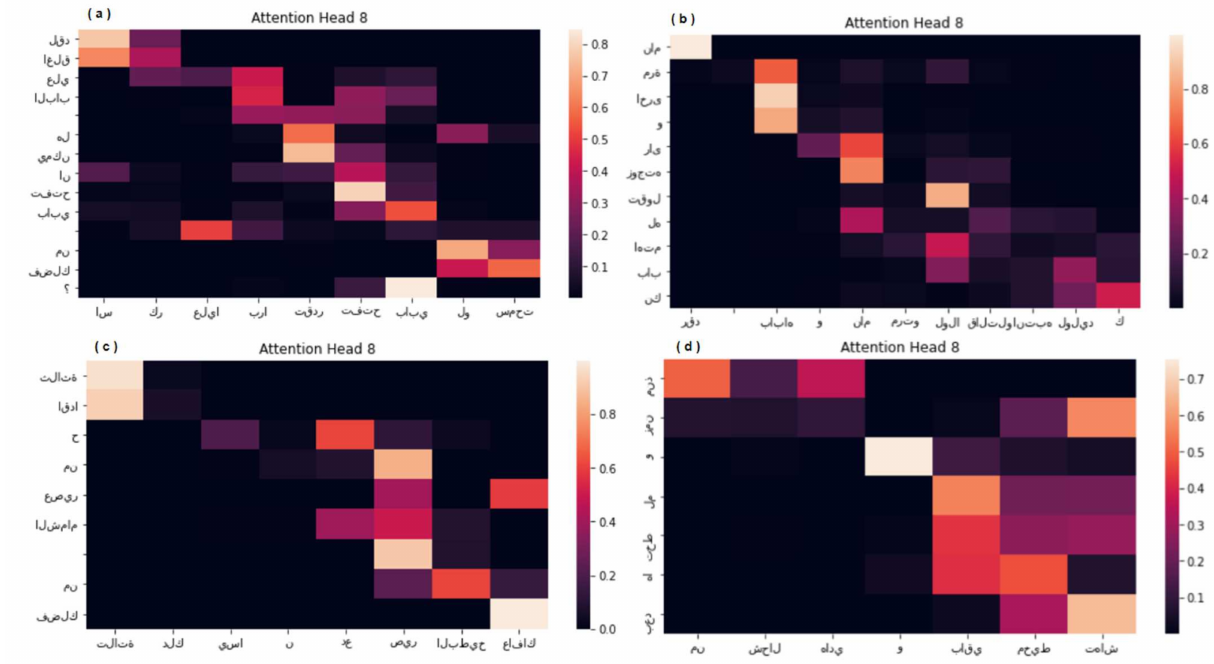
Figure 9. ( a – d ) Four Sample